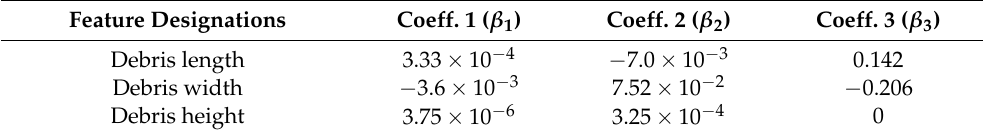
Table 4. Regression coefficients for the disturbance vector (debris dimensions).